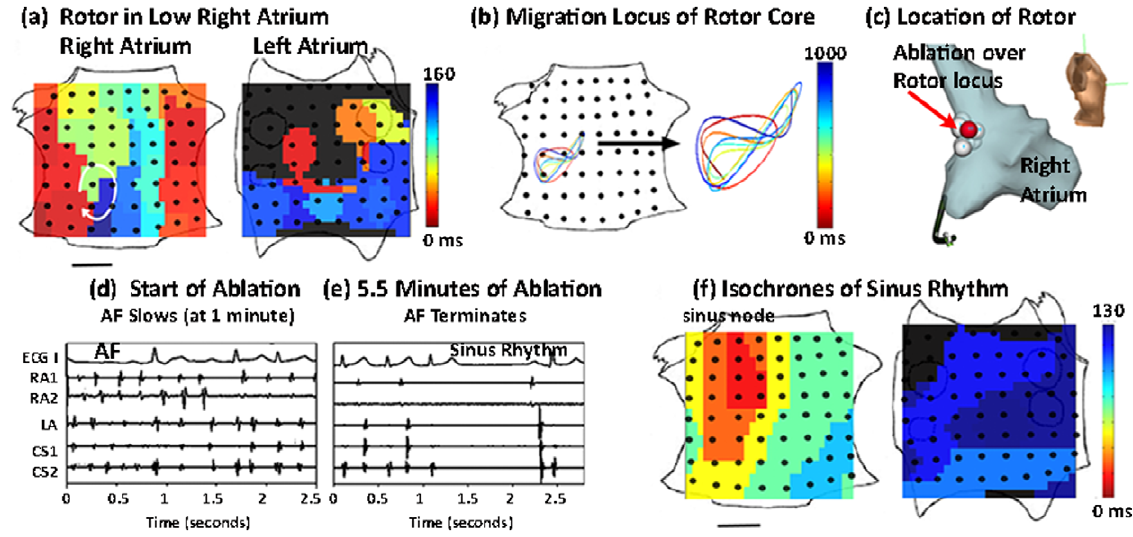
Figure 4. AF Termination by ablation of a Stable RA Rotor. A . Isochrones show a RA rotor and concurrent LA focal beat during persistent AF. B . Spatially constrained rotational center locus. C . Ablation lesions at lateral RA rotor on patient specific geometry (performed 2 hours after initial recording of rotor). A total of 11 lesions were applied (shown), with AF termination to sinus rhythm at 5.5 minutes. The red lesion indicates where ablation terminated AF. D . Electrograms AF terminating to sinus rhythm with localized ablation at rotor (total duration 5.5 minutes) (ECG lead I, intracardiac electrodes in RA, LA and CS). E . Isochrones of sinus rhythm. After ablation, the patient remains AF-free at 12 months on implanted cardiac monitor. Scale bar 1